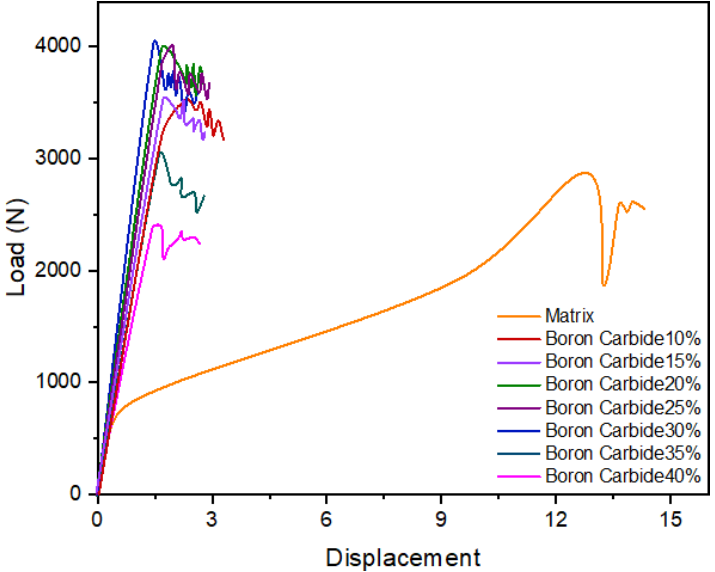
Figure 11. The matrix for bending load displacement and various coatings of B 4 C /Ni63.